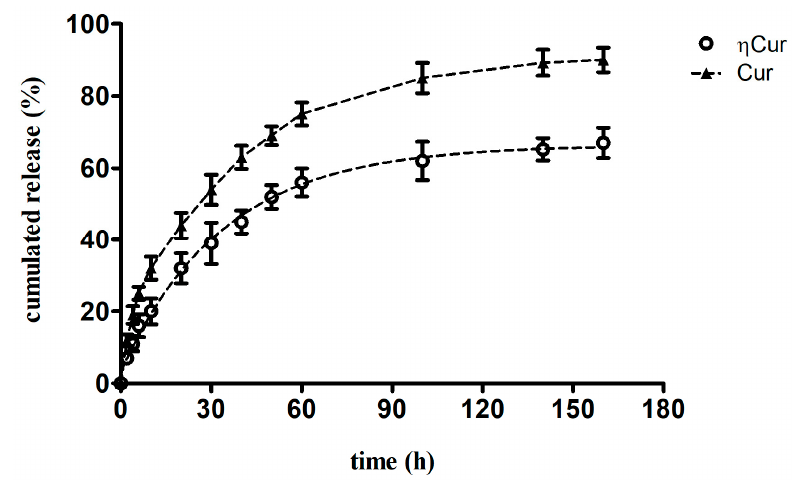
Figure 3. In vitro drug release profiles of curcumin nanoparticles ( η Cur) and free curcumin (Cur) in PBS pH 7.4 and Tween 80. Values presented are mean ± SD of three replications.